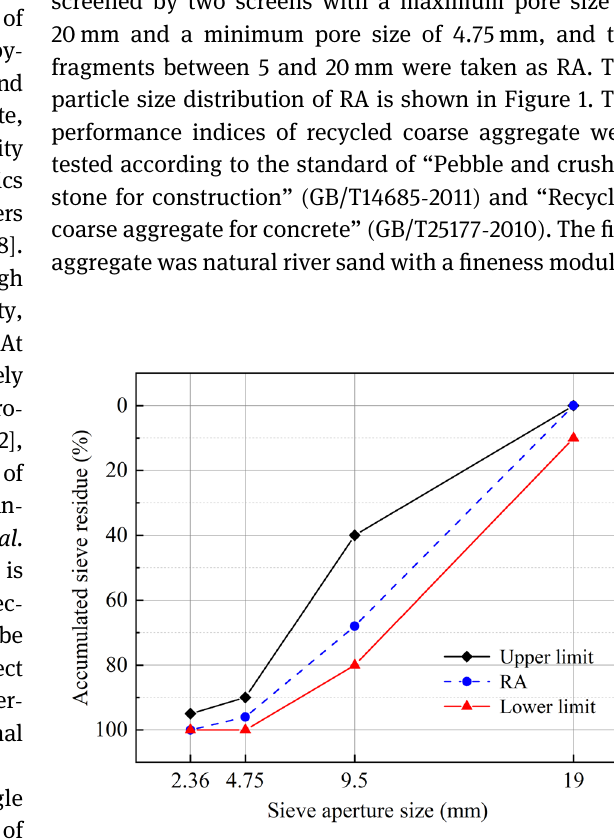
Figure 1: Gradation curve of